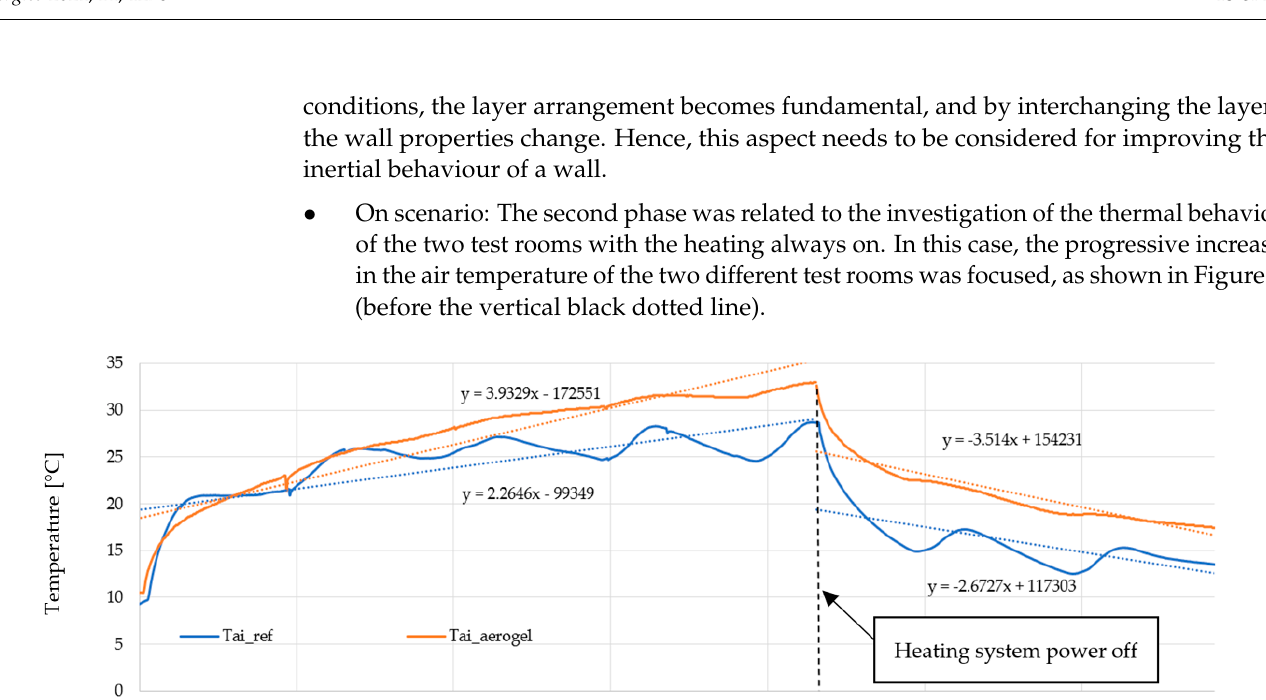
Figure 7. Indoor air temperatures registered in the test rooms during the second scenario.